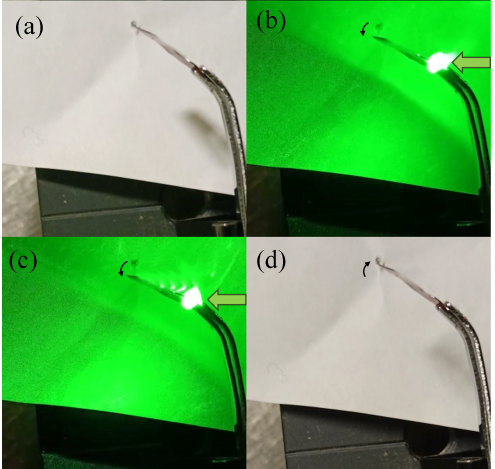
Figure 6. The frames show how the film bent over time under different conditions: ( a ) before being exposed to irradiation, ( b ) after 1 s of irradiation, ( c ) after 2 s of irradiation, and ( d ) after complete relaxation. The irradiation source had a power of 400 mW. The black arrows indicate the direction of movement, while the green arrows represent the direction of the irradiation